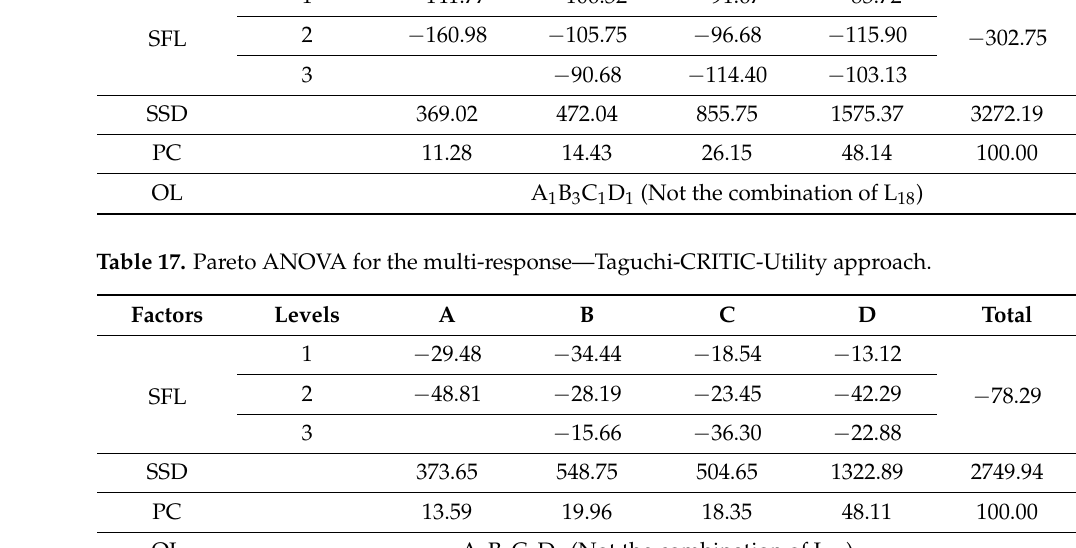
Table 16. Pareto ANOVA for the multi-response—Taguchi-PCA-Utility approach. Factors Levels